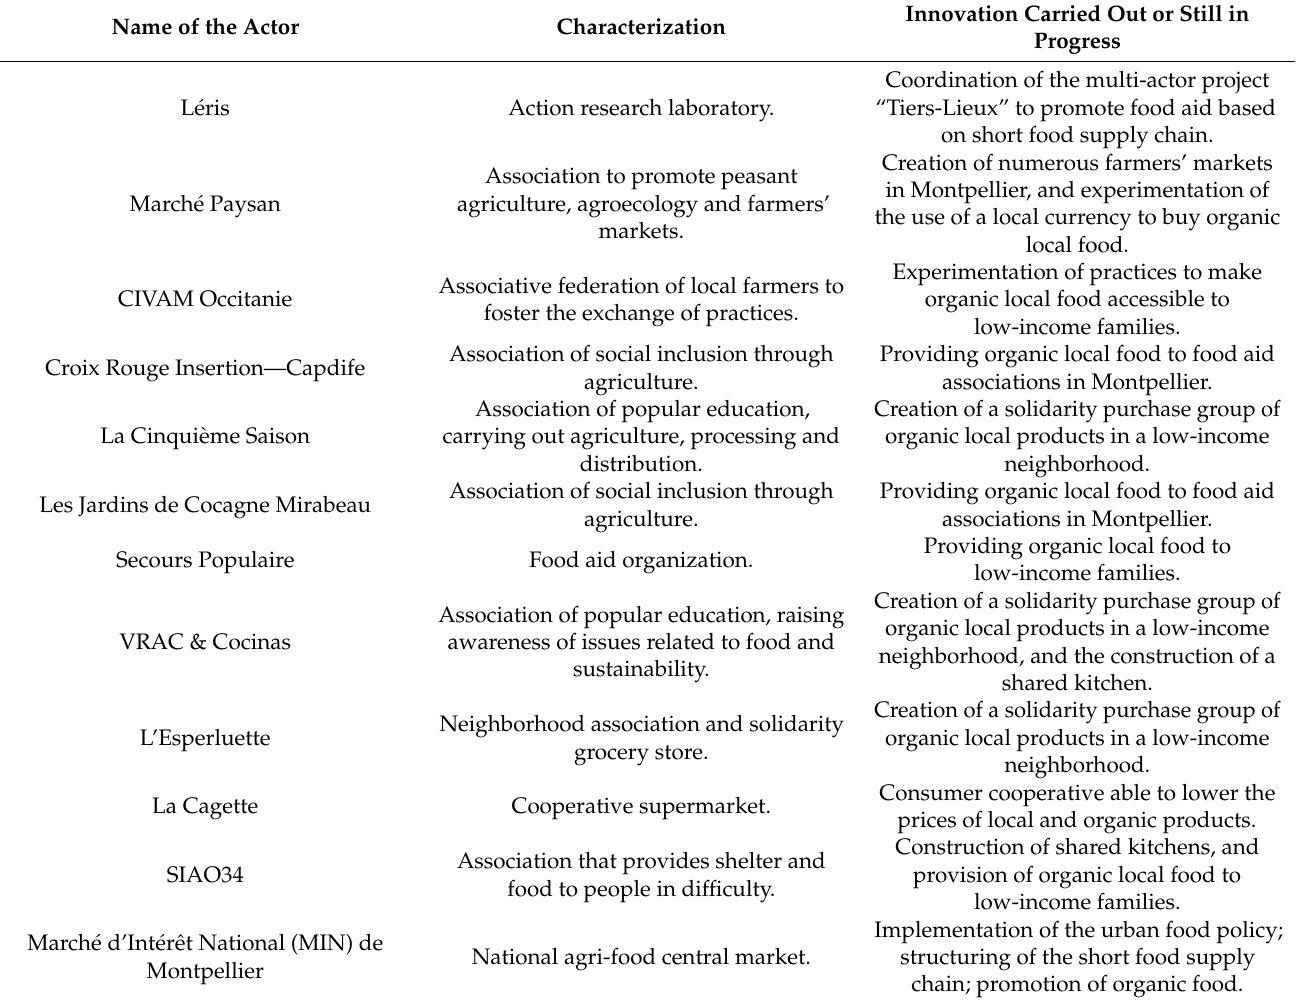
Table 3. Summary of the 12 actors–innovations chosen (elaborated by the